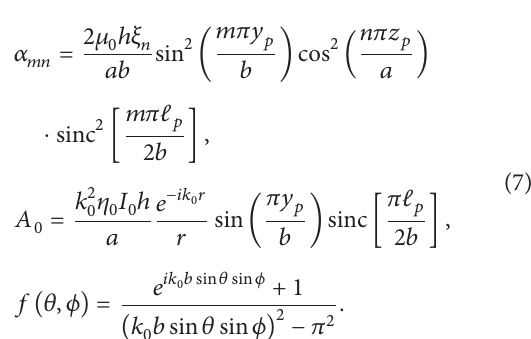
Figure 3: Input impedance of CBHM